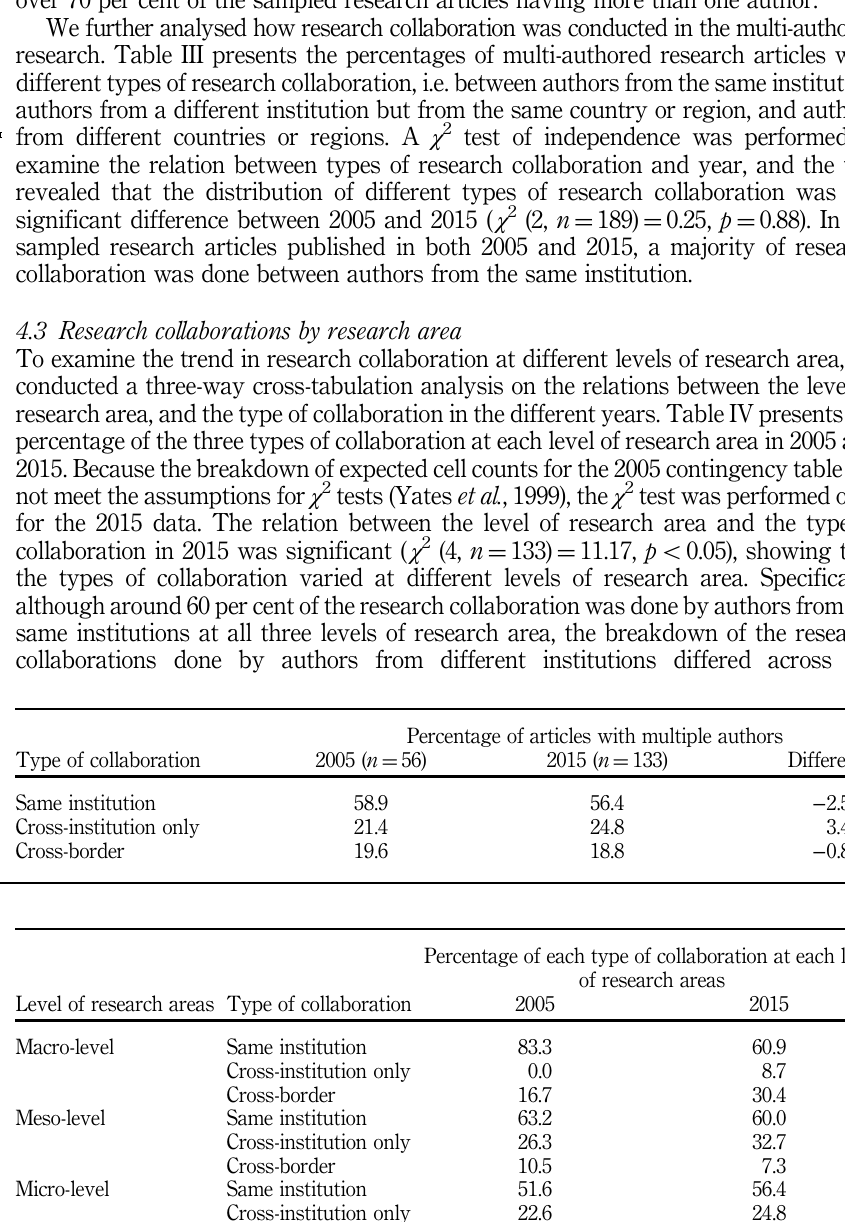
Table IV. Percentage of ODL journal articles by research areas and type of collaboration in 2005 and